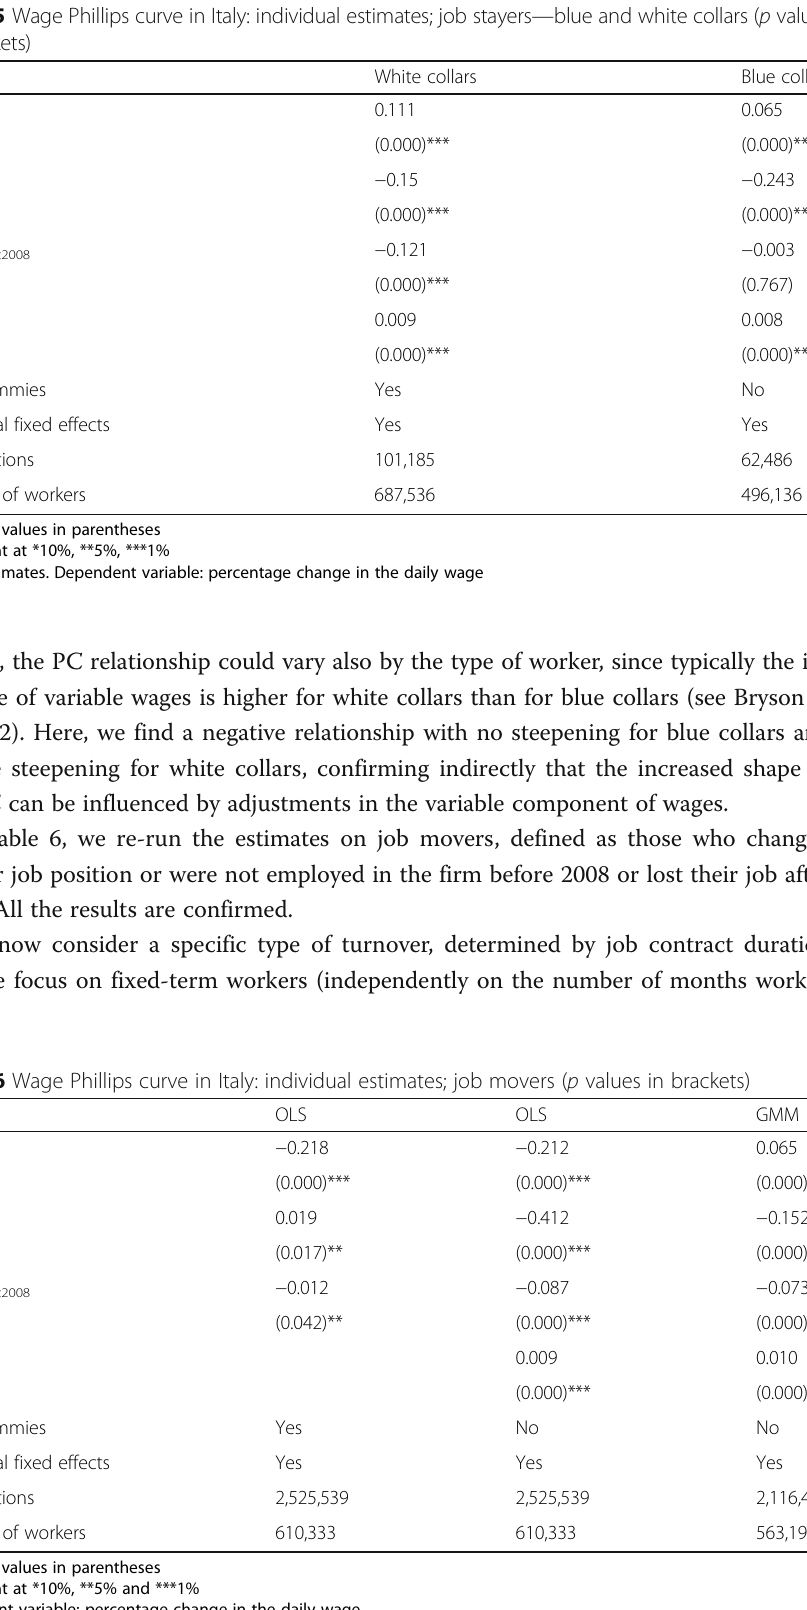
White collars Blue collars (0.000)***